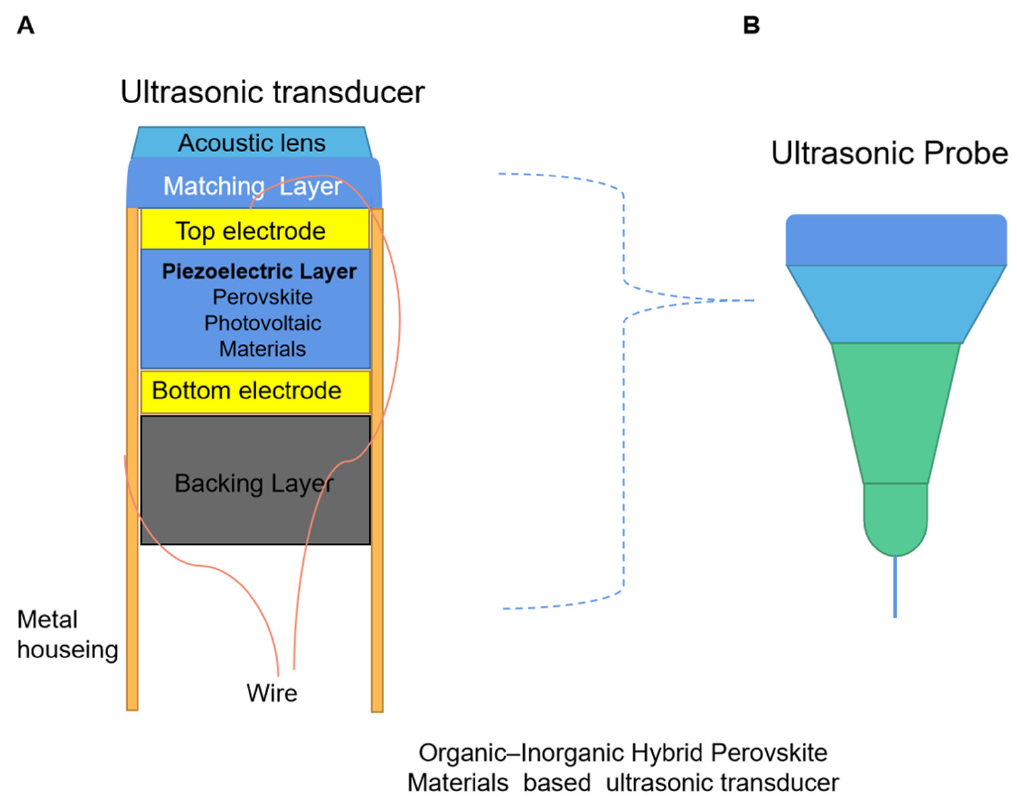
Figure 5. ( A ) Ideal ultrasonic detector based on organic and inorganic perovskite materials. ( B ) The proposed ultrasonic probe in the future based-on organic-inorganic hybrid perovskite materials.